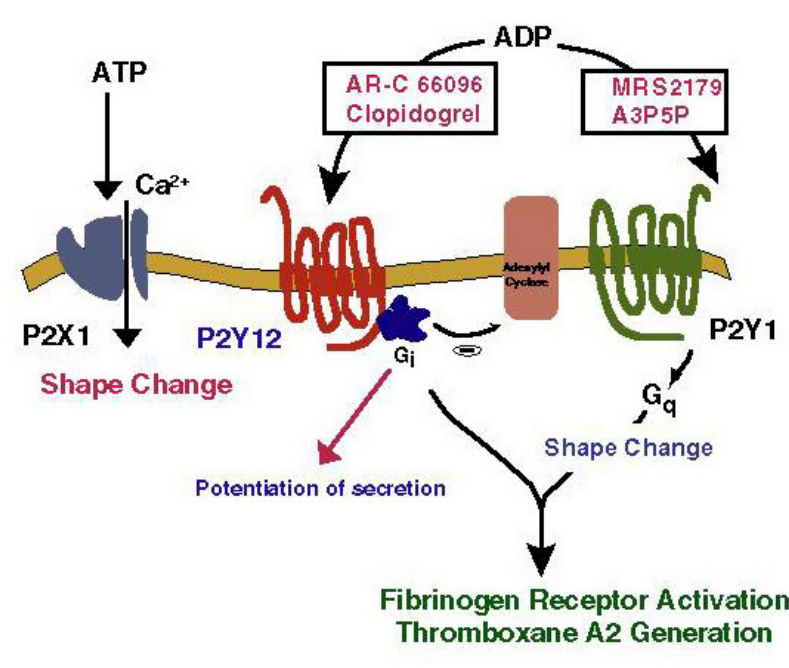
FIGURE 1 . Role of P2 receptor subtypes in platelet